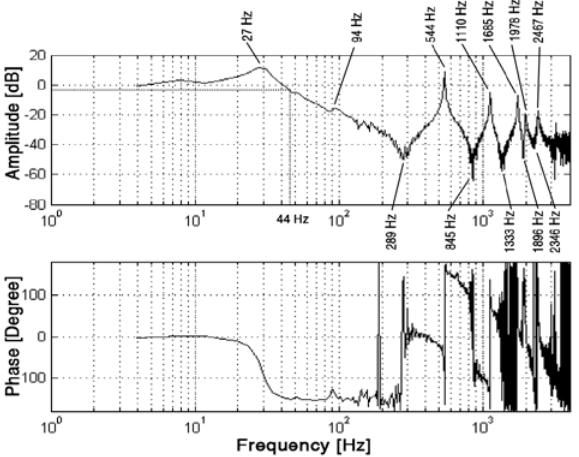
Fig. 2. Poles and zeros of the frequency response of the speed loop.